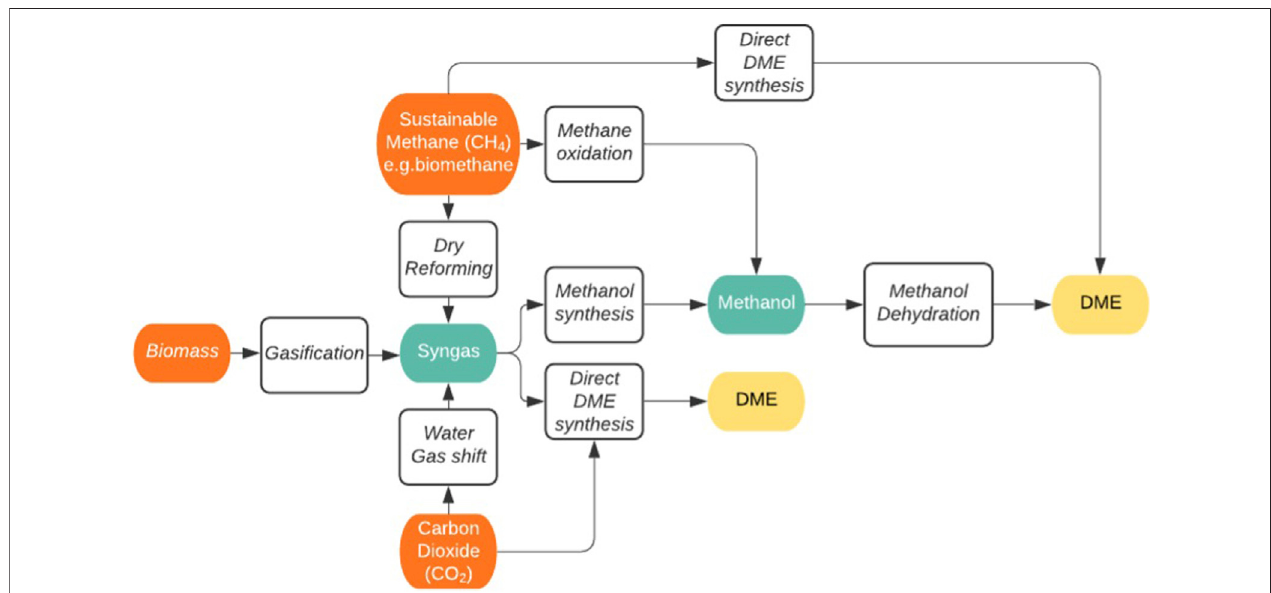
FIGURE 6 | Synthesis of DME using different carbon